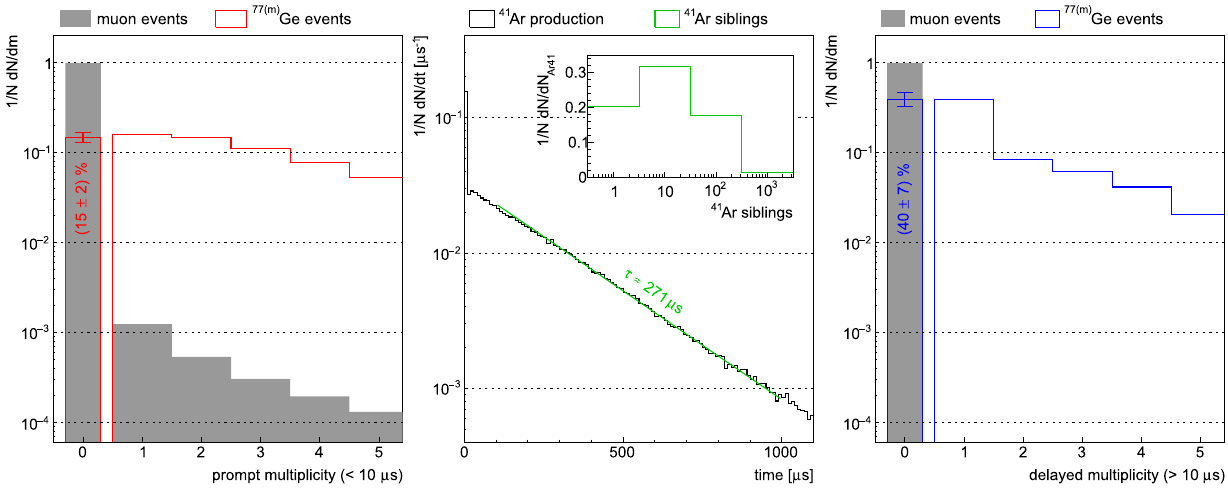
Fig. 5 Left:Prompt germaniumdetectormultiplicityforevents tagged as muon event and events with 77 ( m ) Ge production. Only (15 ± 2)% of the 77 ( m ) Ge events do not show prompt coincidence between muon veto andgermaniumdetectors.Middle:Timingof 41 Arproduction.Theinset